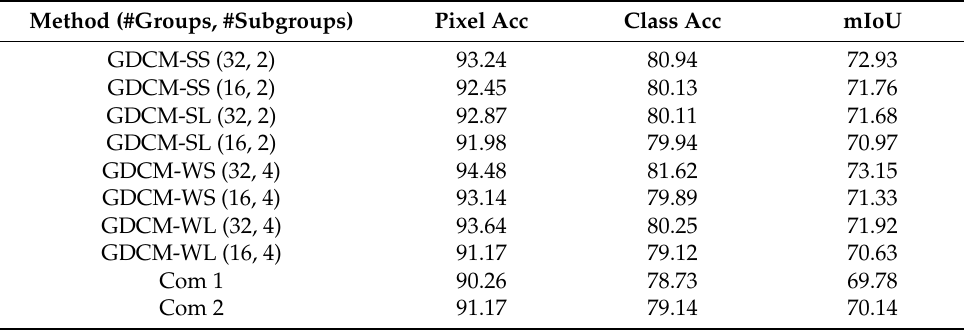
Table 4. Comparison of accuracy per method (unit: %).